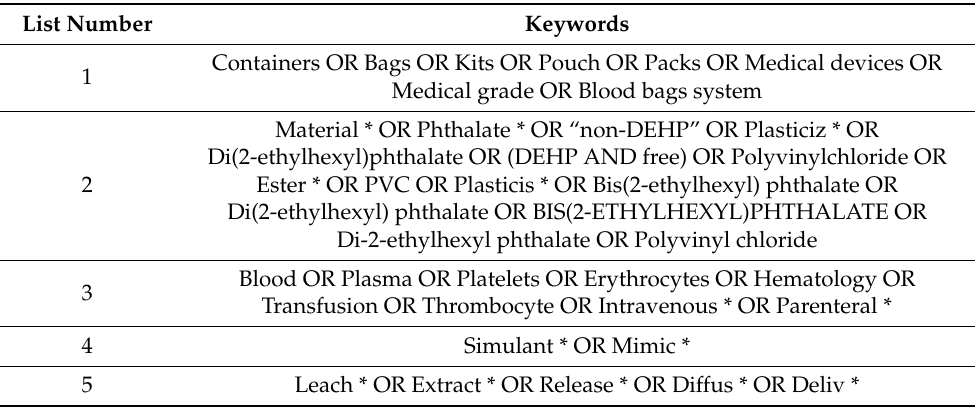
Table 1. Set of keywords (queries) used in the literature